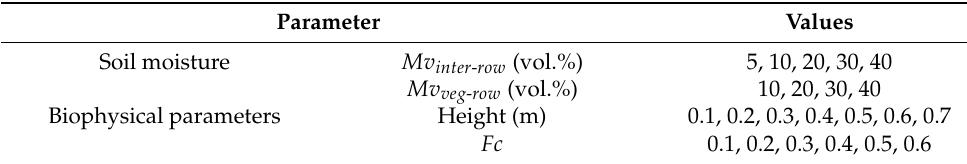
Table 3. The parameter values variation used in model simulation: soil moisture (vol.%) and pepper parameters (height and cover fraction Fc